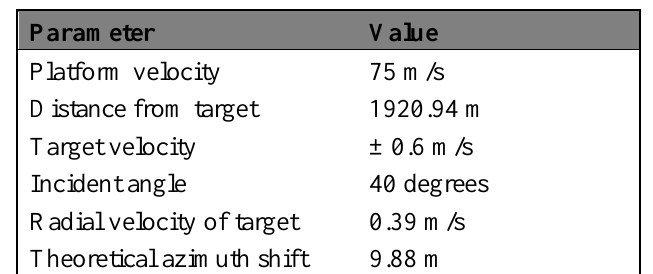
Table 2. Simulation parameters of moving target case.